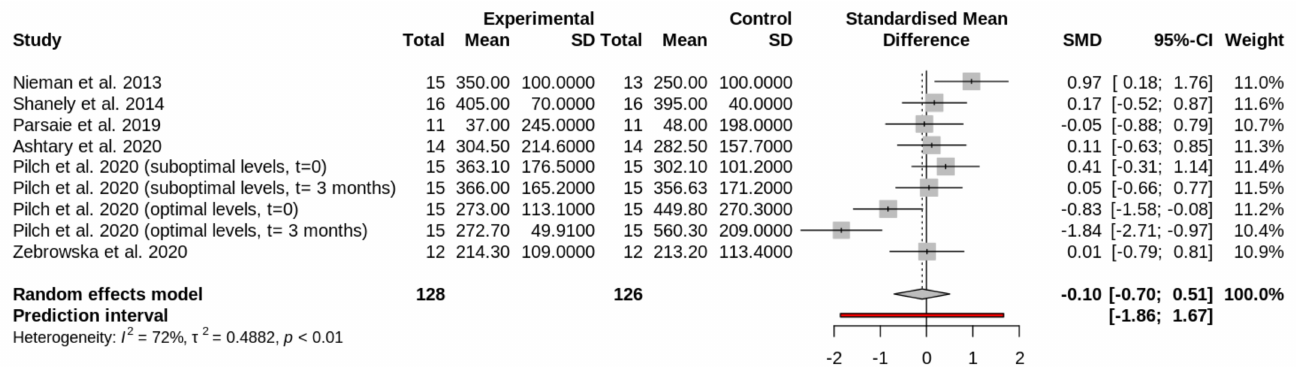
Figure 2. Forest plot comparing the effects of vitamin D supplementation on circulating CK levels after exercise. The squares in the forest plot on the left side of the line represent studies or groups in which the mean of the experimental group (supplemented) was lower than the mean of the control group (placebo). The ones in the right side indicate the